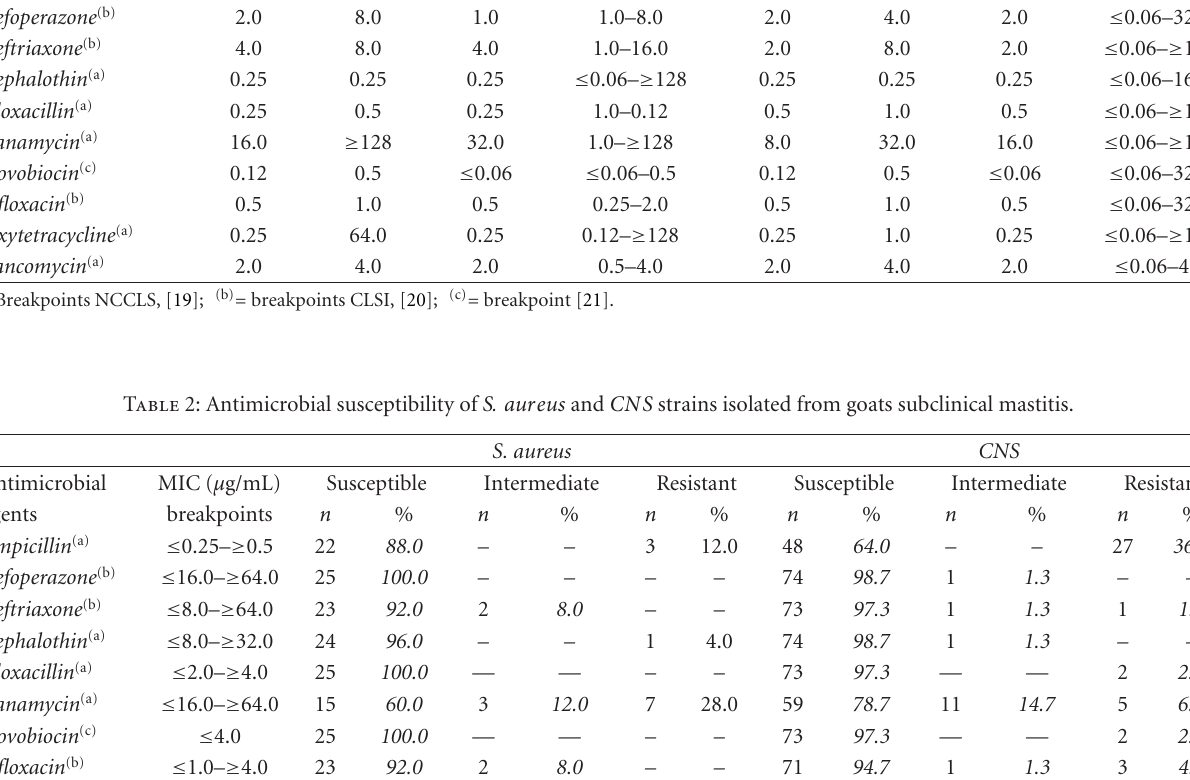
Table 1: MIC ( μ g/mL) of antimicrobials against S. aureus and CNS strains isolated from goats subclinical mastitis. S. aureus CNS Antimicrobial agents